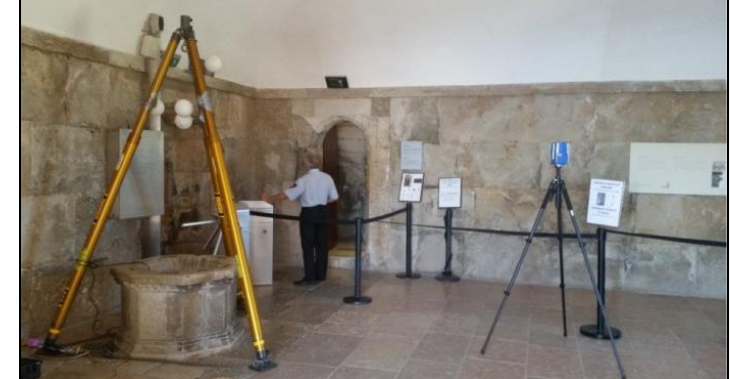
Figure 10. Structure required to access the cistern.